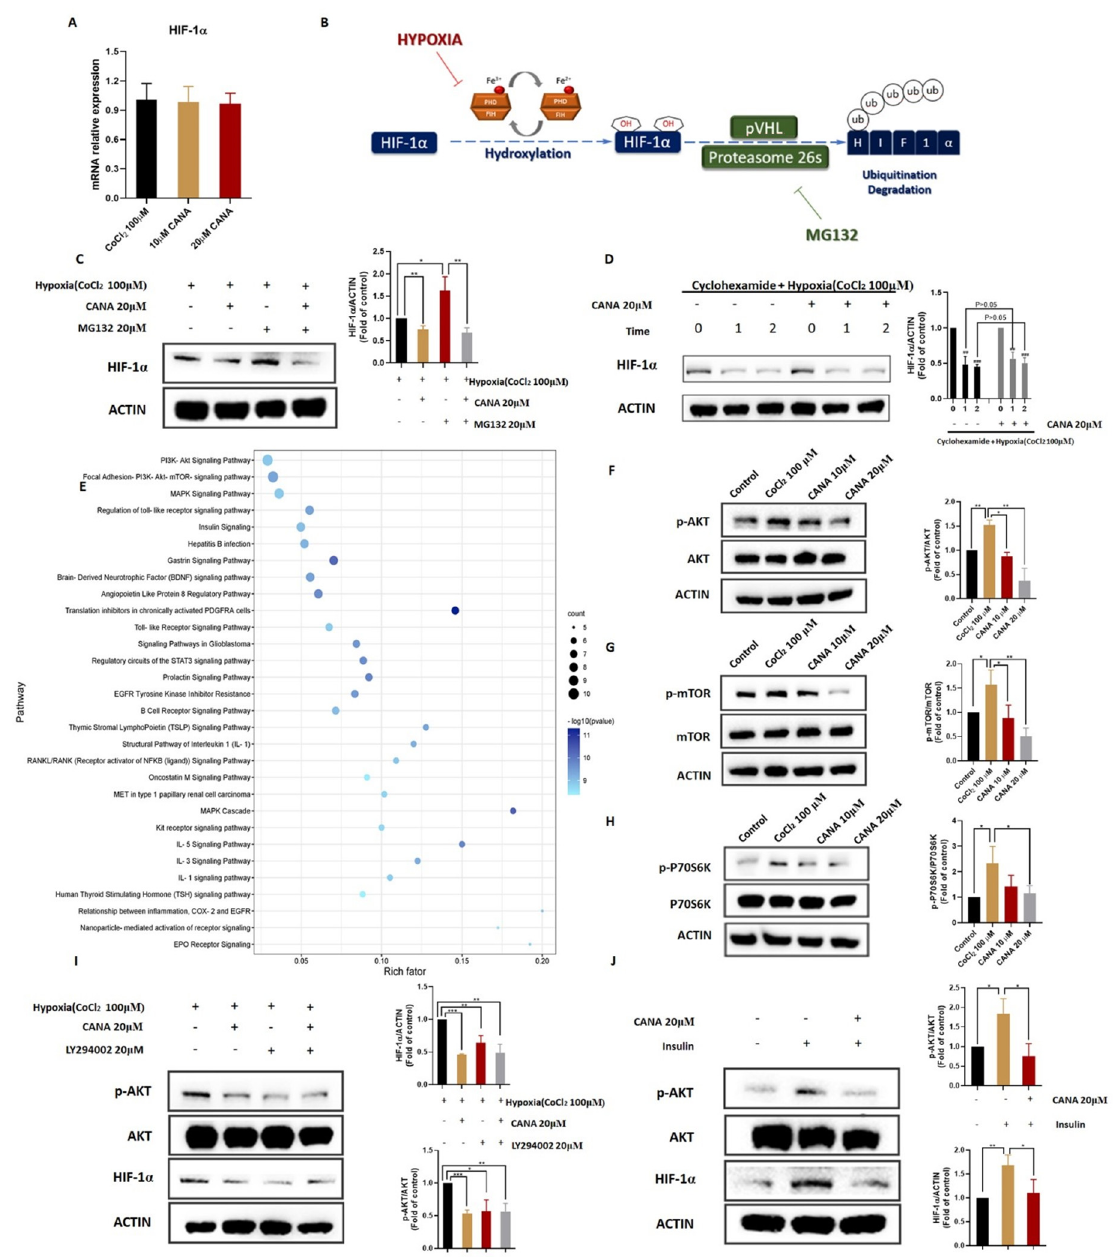
Figure 6. CANA triggered HIF-1 α reduction through the AKT/mTOR pathway through inhibiting HIF-1 α